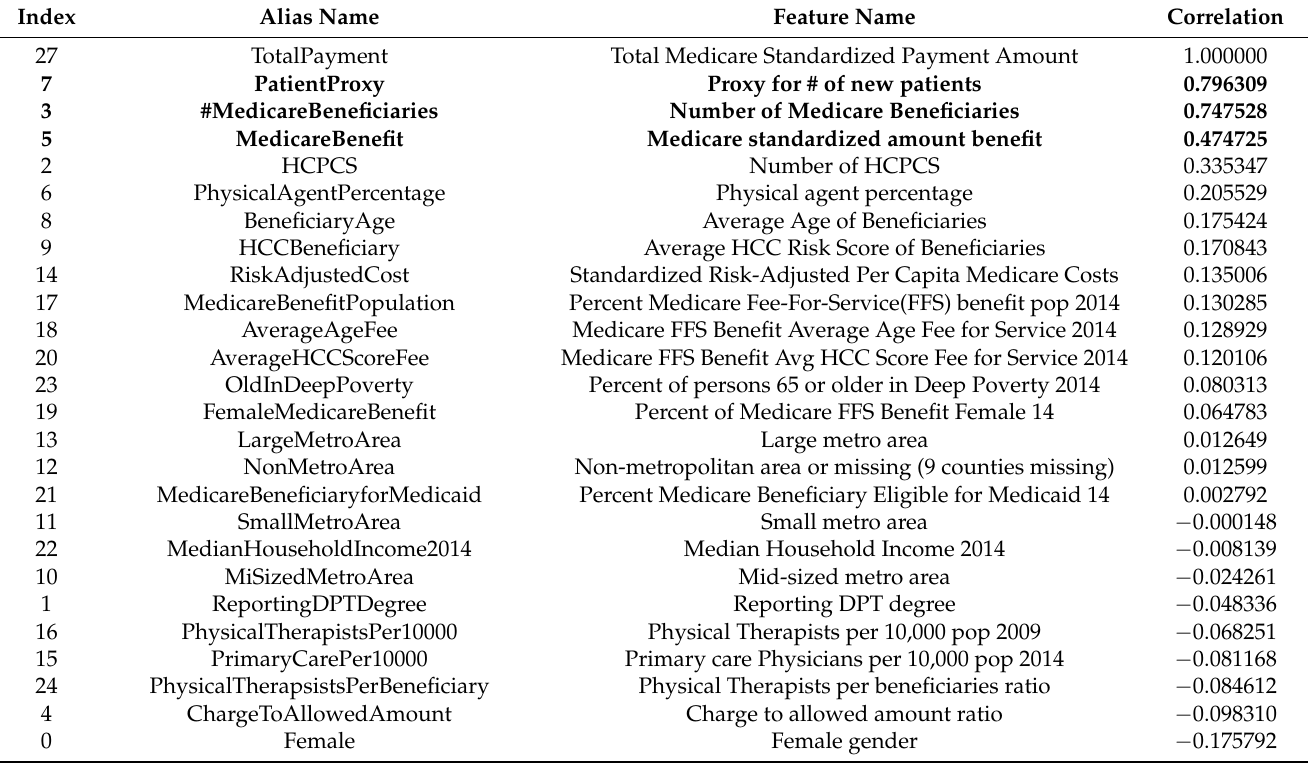
Table 2. Linear relationship of training variables with the predicted